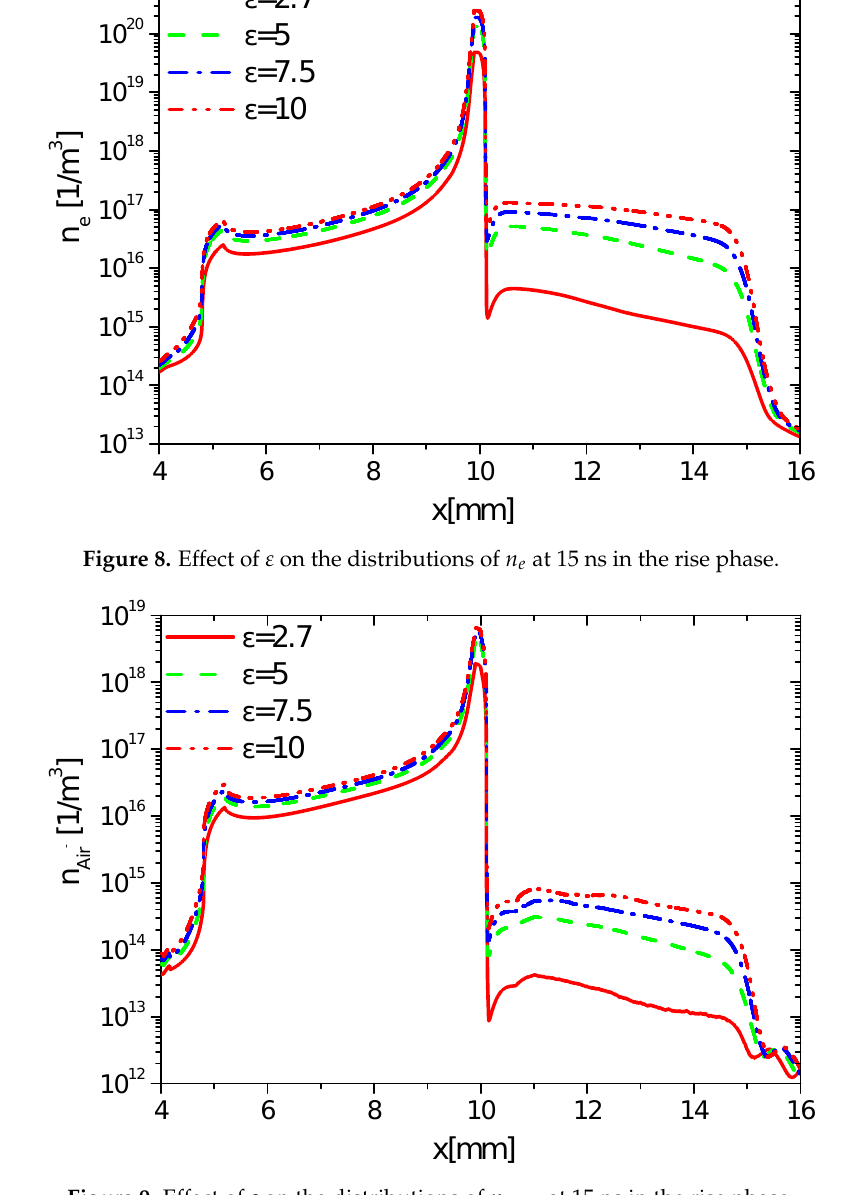
Figure 9. Effect of ε on the distributions of n Air − at 15 ns in the rise